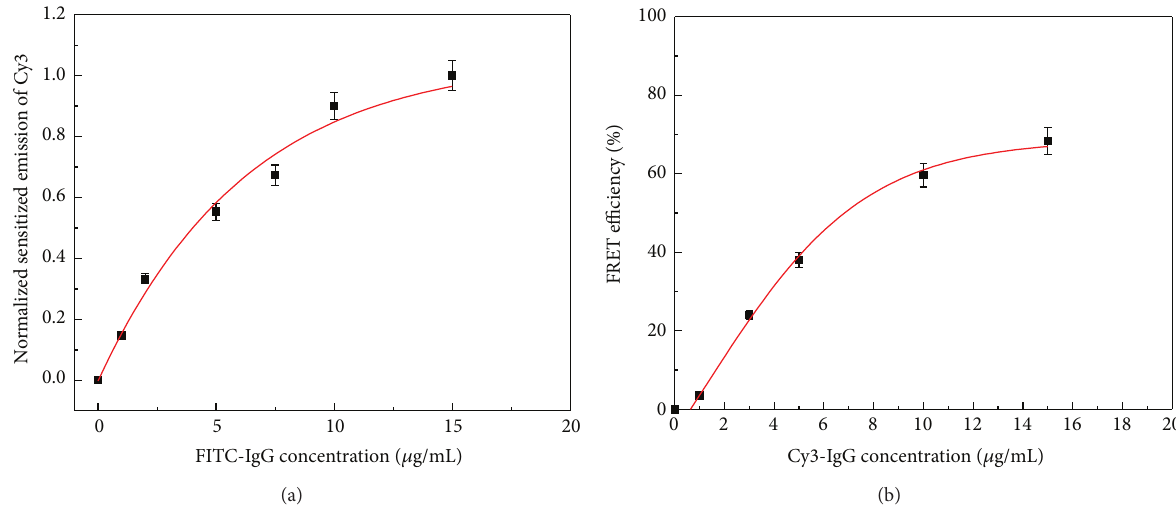
Figure 3: Fluorescence resonance energy transfer when two dyes Cy3-IgG and FITC-IgG were used in this combined Ag/Ab immunoassay system. (a) Cy3 fluorescent intensity differences ( Δ𝐼 ) when the concentration of FITC-IgG was changed from 0, 1.0, 2.0, 5.0, 7.5, and 10.0 𝜇 g/mL. Cy3-IgG was fixed at 2.0 𝜇 g/mL. 480–550 nm band-pass excitation filter, 570 nm DM, and 590 nm long pass emission filter sets wereused.Exposuretimewas600 ms.Otherconditionswerethesame.(b)FITCfluorescentintensitydifferences( Δ𝐼 )whentheconcentration